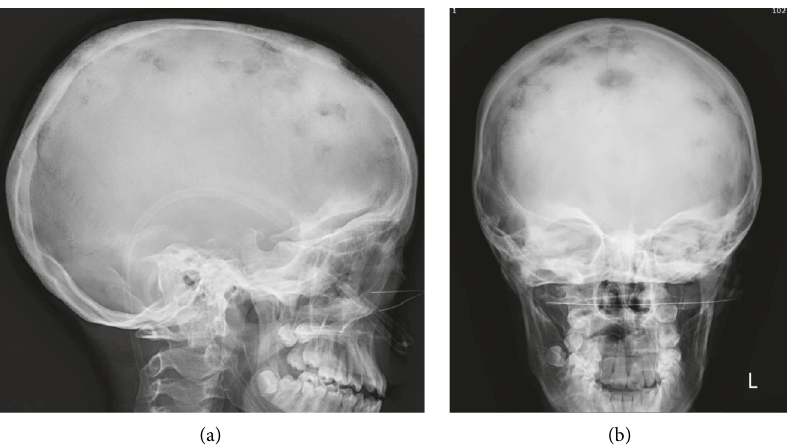
Figure 7: (a) and (b) Skull X-ray of the 13 years old girl with MSMD from Ethiopia: multiple trans-diploic lesions with inner and outer calvarial bone destruction; findings were suggestive of delayed/arrested sphenoid sinus pneumatization.